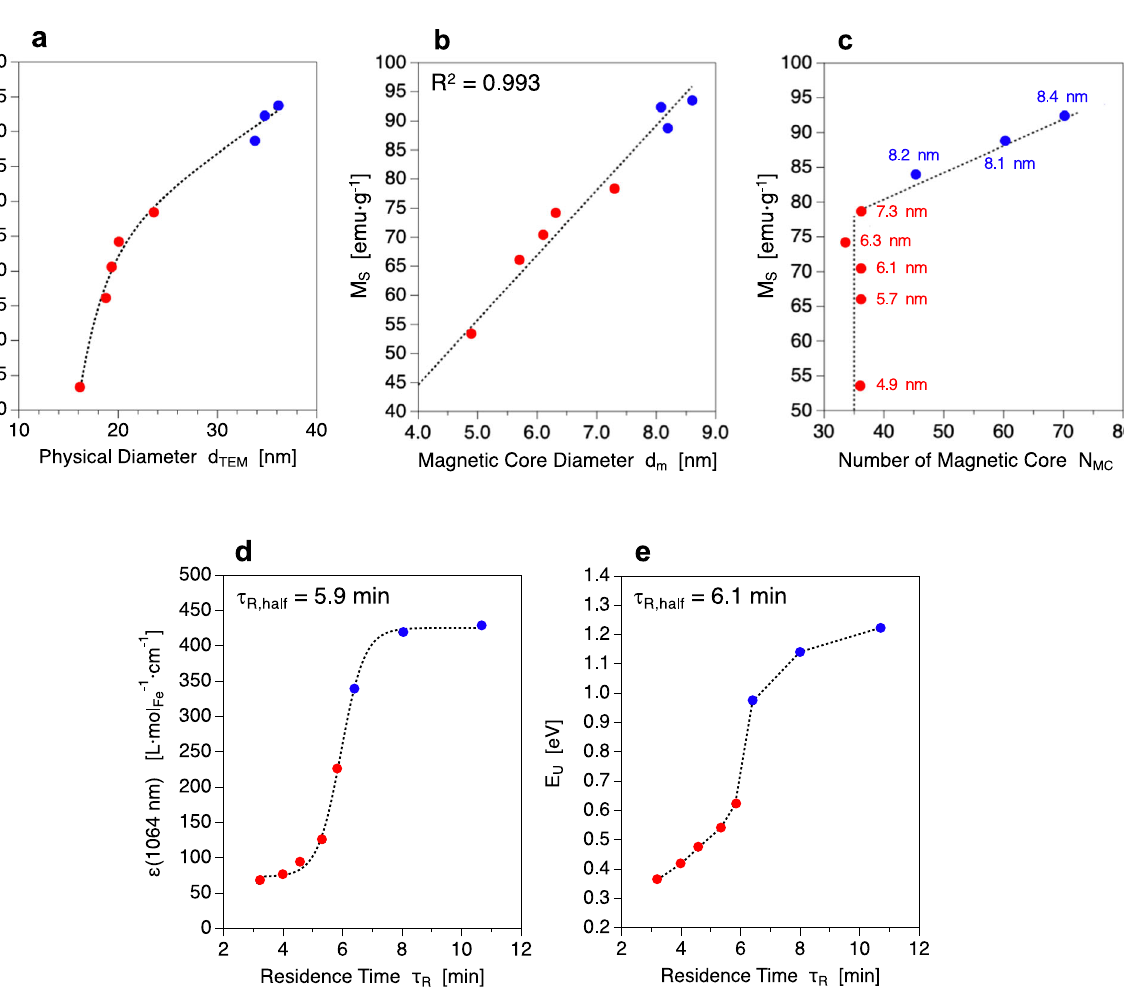
Fig. 2 Evolution of NFs static magnetic properties and optical characteristics with nanostructural features and residence time. a – c Saturation magnetization dependency on the physical diameter, magnetic core diameter and number of magnetic cores, respectively. d , e Evolution of the extinction coef fi cient and Urbach energy with residence time, respectively. Please note that the sizes on Fig. 2c correspond to the magnetic core